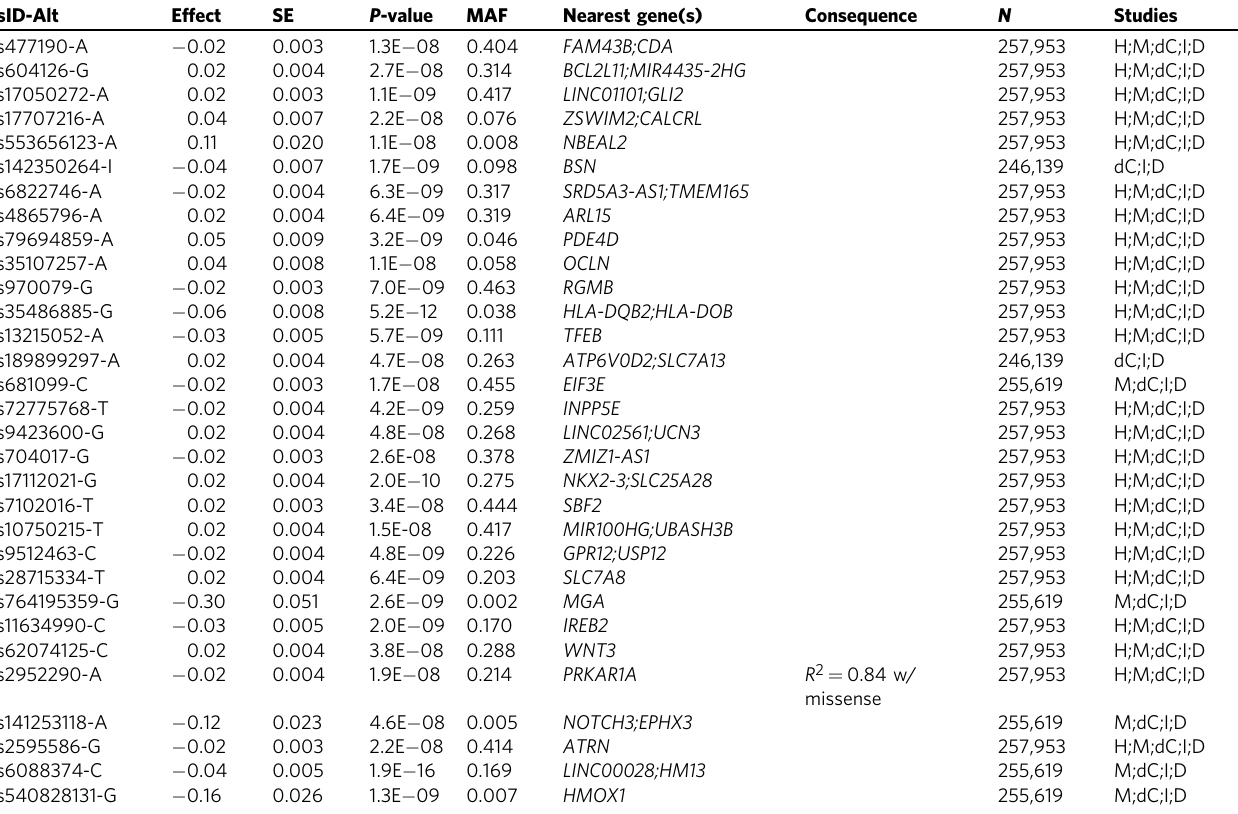
Table 2 Novel loci associated with the iron status biomarker ferritin in a genome-wide association